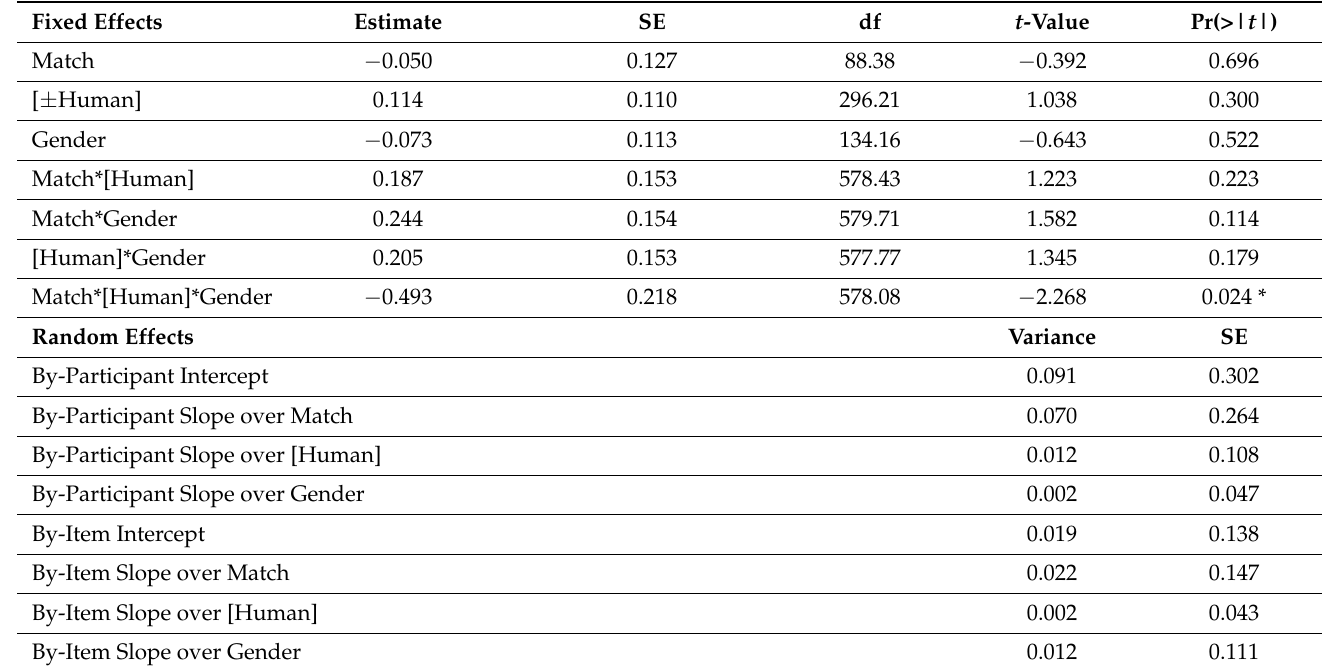
Table 9. Linear mixed-effects model, Region 7-SPR, L2